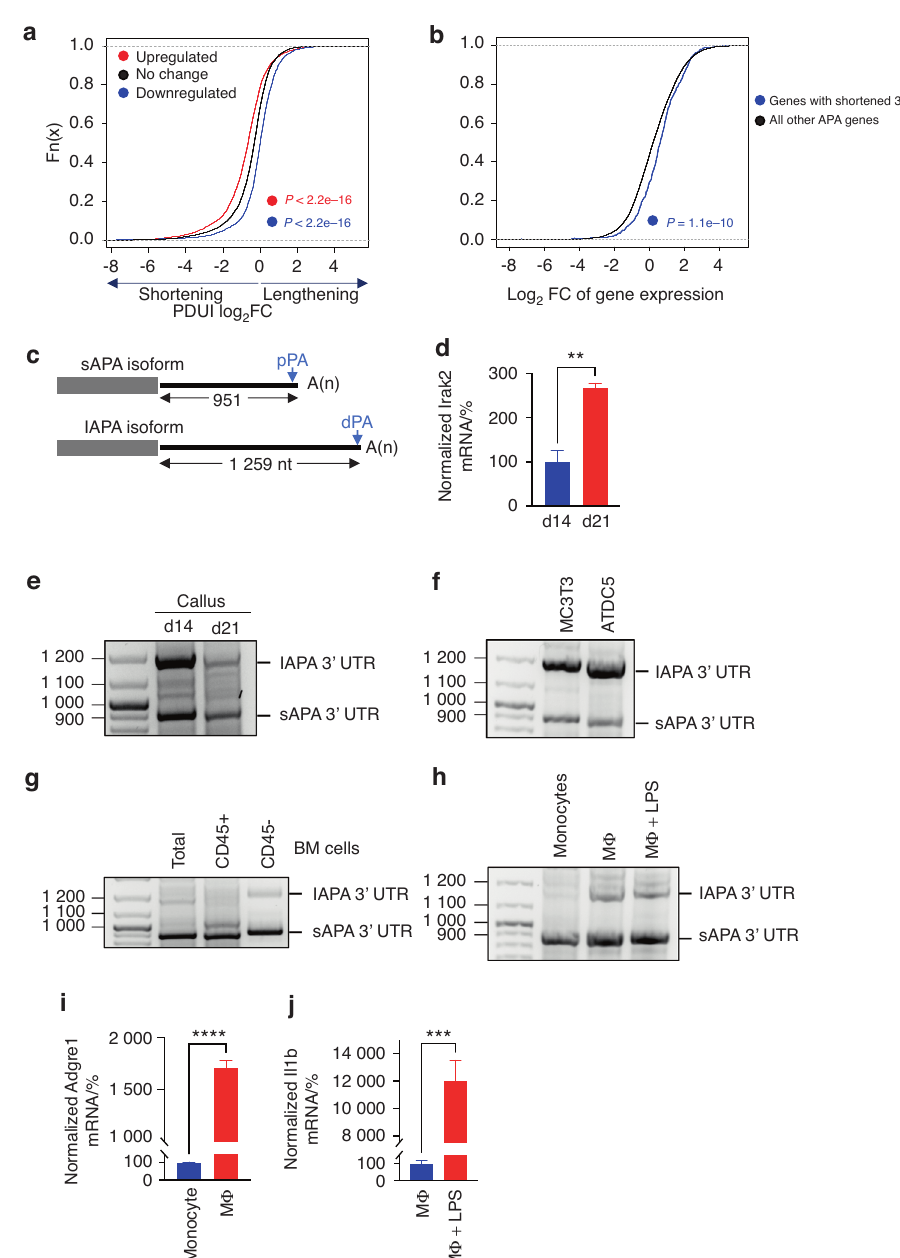
Fig. 7 3 ′ UTR shortening is associated with increased gene expression. a Cumulative distribution function (CDF) curves of the PDUI log 2 FC values (generated by InPAS) of genes whose expression was signi fi cantly upregulated (red line), signi fi cantly downregulated (blue line), or unchanged (black line) on d21 relative to d14. A signi fi cant change in gene expression was de fi ned as P adj < 0.05. All the InPAS-identi fi ed APA events are included in the analysis (see Fig. S14a for APA events identi fi ed by APAlyzer). p values (K-S test) indicating the signi fi cance of the difference between the red or blue and black genes are indicated. b CDF curves comparing the expression of genes that exhibited signi fi cant 3 ′ UTR shortening according to InPAS (blue line) and all other genes (black line). P values (K-S test) are based on comparisons of the blue and black genes (see Fig. S14b for APAlyzer data). c Schematic of the lAPA and sAPA isoforms of Irak2. d RT ‒ qPCR analysis of Irak2 expression in d14 and d21 calli. The mRNA expression level of Irak2 was normalized to that of β -actin, and the normalized level in d14 calli was de fi ned as 100. Representative gel image of Irak2 3 ′ RACE-PCR products from d14 and d21 calli ( e ), differentiated MC3T3 and ATDC5 cells ( f ), total, CD45 + , and CD45 − bone marrow (BM) cells ( g ), monocytes, macrophages (M Φ ), and LPS-stimulated M Φ ( h ). i As in d , except the expression of the M Φ marker Adgre1 was measured. The results indicate successful in vitro differentiation of monocytes to M Φ . j As in d except that Il1b mRNA expression was measured. The results indicate upregulated expression of the proin fl ammatory Il1b gene in response to LPS stimulation. The bar graphs present the average ± SEM. ** P < 0.01; *** P < 0.001; **** P < 0.000 1 using unpaired Student ’ s t (CD45 + ) and nonimmune (CD45 − ) cells; we found that the sAPA exhibited barely detectable expression of the lAPA isoform (Fig. 7f, g). To further identify the APA isoforms expressed in different isoform is the major isoform in both populations (Fig. 7g). Then, to bone marrow cell populations, we fractionated the bone marrow, investigate Irak2 APA isoform expression in bone marrow myeloid using fl uorescence-activated cell sorting (FACS), into immune cells, we isolated primary monocytes from the bone marrow and